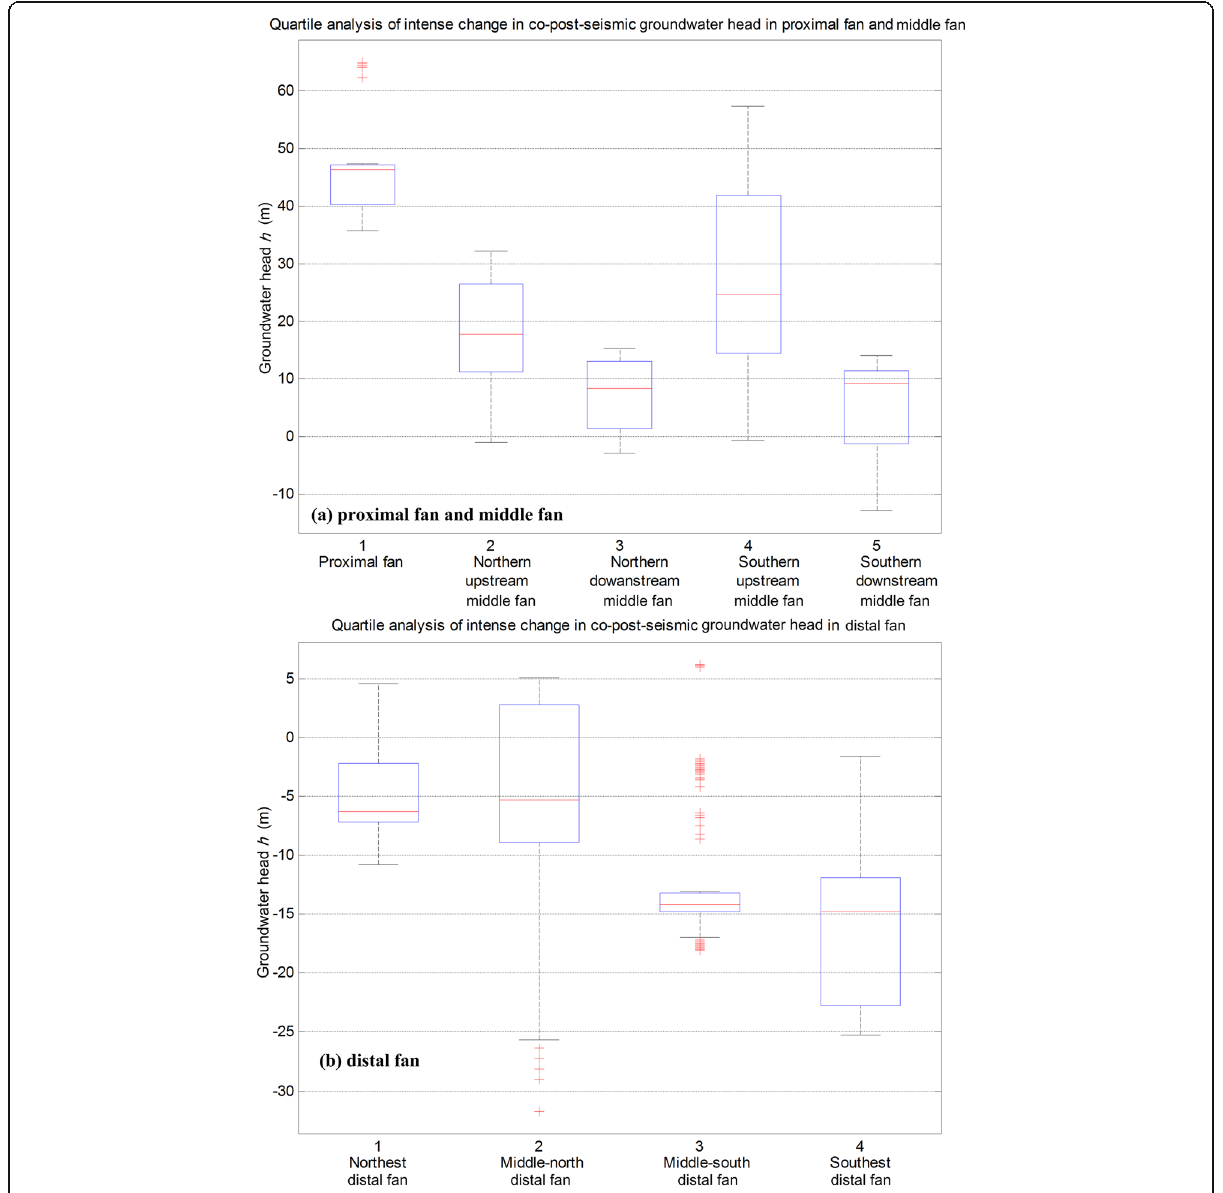
Fig. 6 Hot zones of intense change in co-post-seismic hourly groundwater head by using quartile analysis in a proximal fan and middle fan and b distal